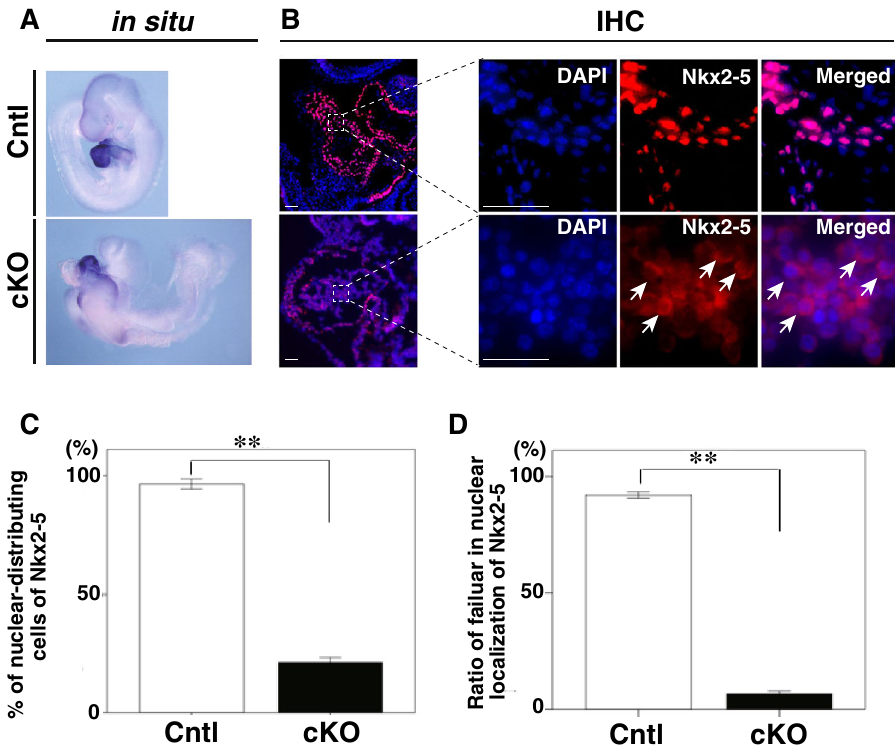
Figure 2. Lack of nuclear localization of Nkx2-5 in Smad4 -cKO embryonic hearts. ( A ) Whole-mount ISH of control and Smad4 -cKO embryos with a probe for Nkx2-5 at E9.5. ( B ) Immunofluorescent staining of sagittal sections of control and Smad4 -cKO embryos at E9.5 using anti-Nkx2-5 antibodies (red) and DAPI for detection of nuclei (blue). Arrows indicate the lack of nuclear localization of Nkx2-5. H, heart. Scale bar = 100 μm. ( C and D ) Percentage of Nkx2-5 protein distributing cell in control and Smad4 -cKO embryonic hearts ( C ) and the percentage of cells showing nuclear localization of Nkx2-5 in control and Smad4 -cKO embryonic hearts ( D ). Data were collected from 10 sections for each embryo (n = 3 and 3 for control and Smad4 -cKO, respectively). Data are presented as mean ± SEM, ** P < 0.01 (Mann–Whitney U